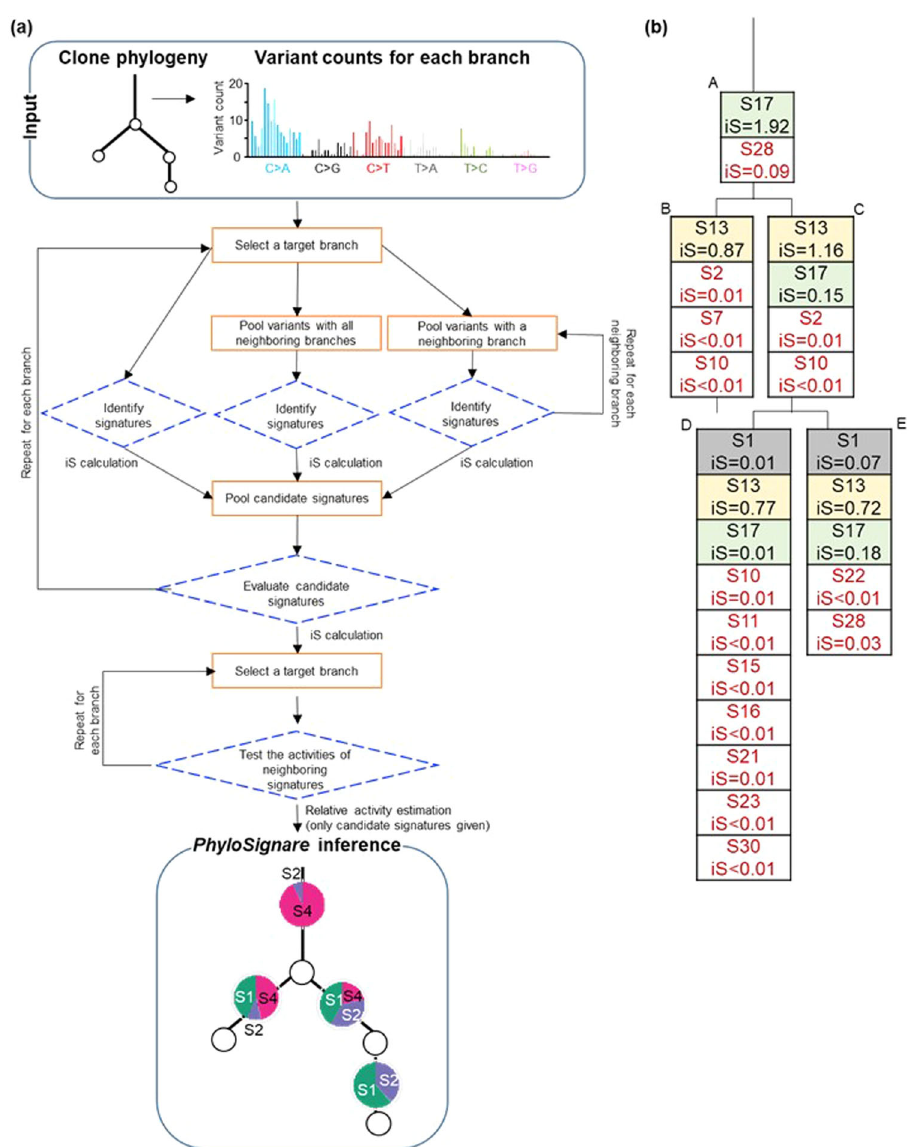
Fig. 3 Overview of PhyloSignare approach. a Our approach uses a clone phylogeny in which all variants are mapped along branches. PhyloSignare pools mutations with adjacent branches and collect candidate signatures for each branch. We use iS statistics (see text) to evaluate the presence of each candidate signature. Last, we test if signatures from neighboring branches are active at a branch. Signatures will be detected for each branch. b We used variants for each branch and detected signatures by using QP. Detected signatures and iS are shown in a box. Signatures with red letters are incorrect detection, and iS values were relatively